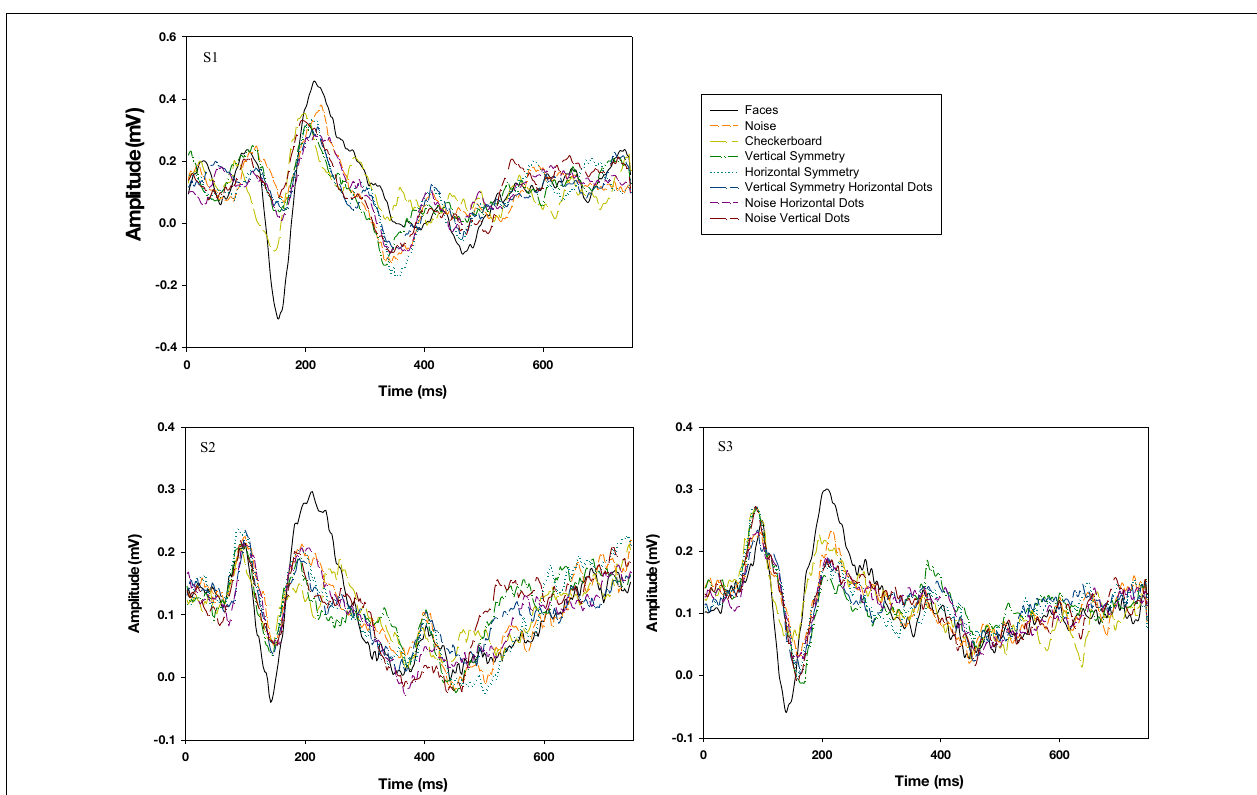
FIGURE 13 | Evoked potentials for face images or different variants of the noise images for three observers. Responses to realistic faces are shown by the black trace and elicit the only clear N170